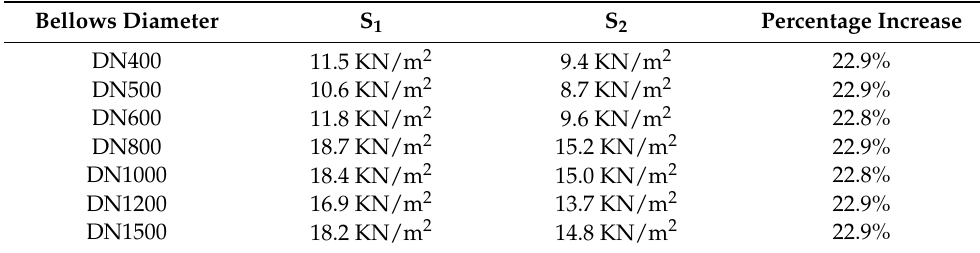
Table 6. Comparison of ring stiffness of bellows with different pipe diameters.